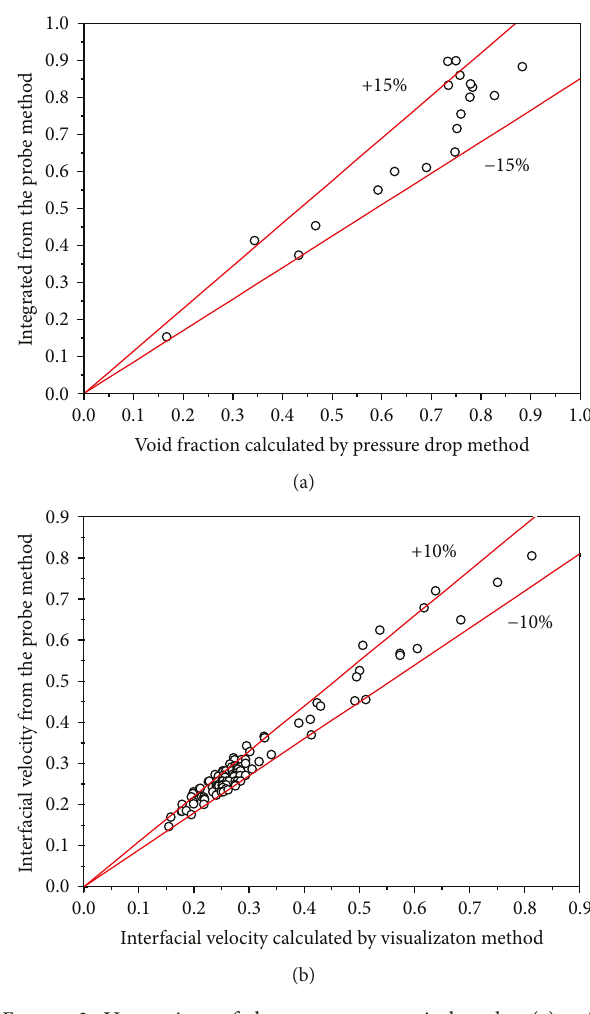
Figure 2: Uncertainty of the two-sensor optical probe: (a) void fraction; (b) interfacial